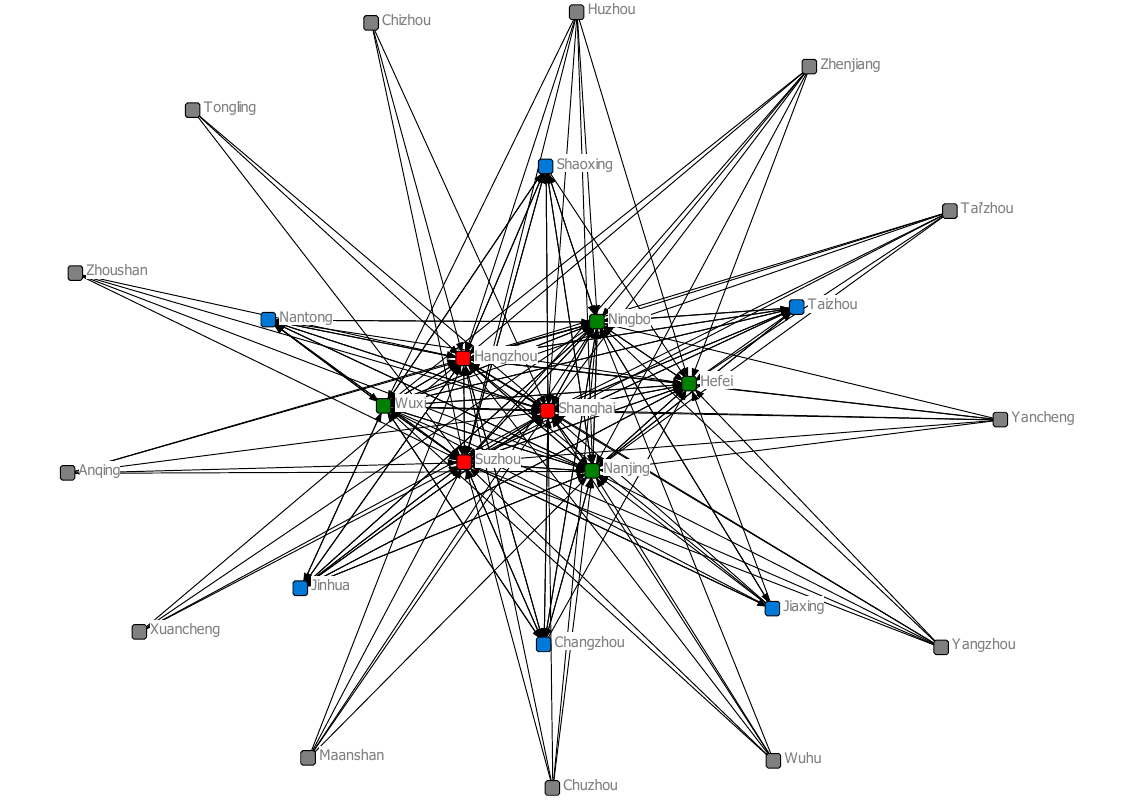
Figure 6. The directional network structure of the YRDUA. Table 2. Individual index of city nodes in the YRDUA network. City Outdegree Indegree Outcloseness Incloseness Betweenness NO.